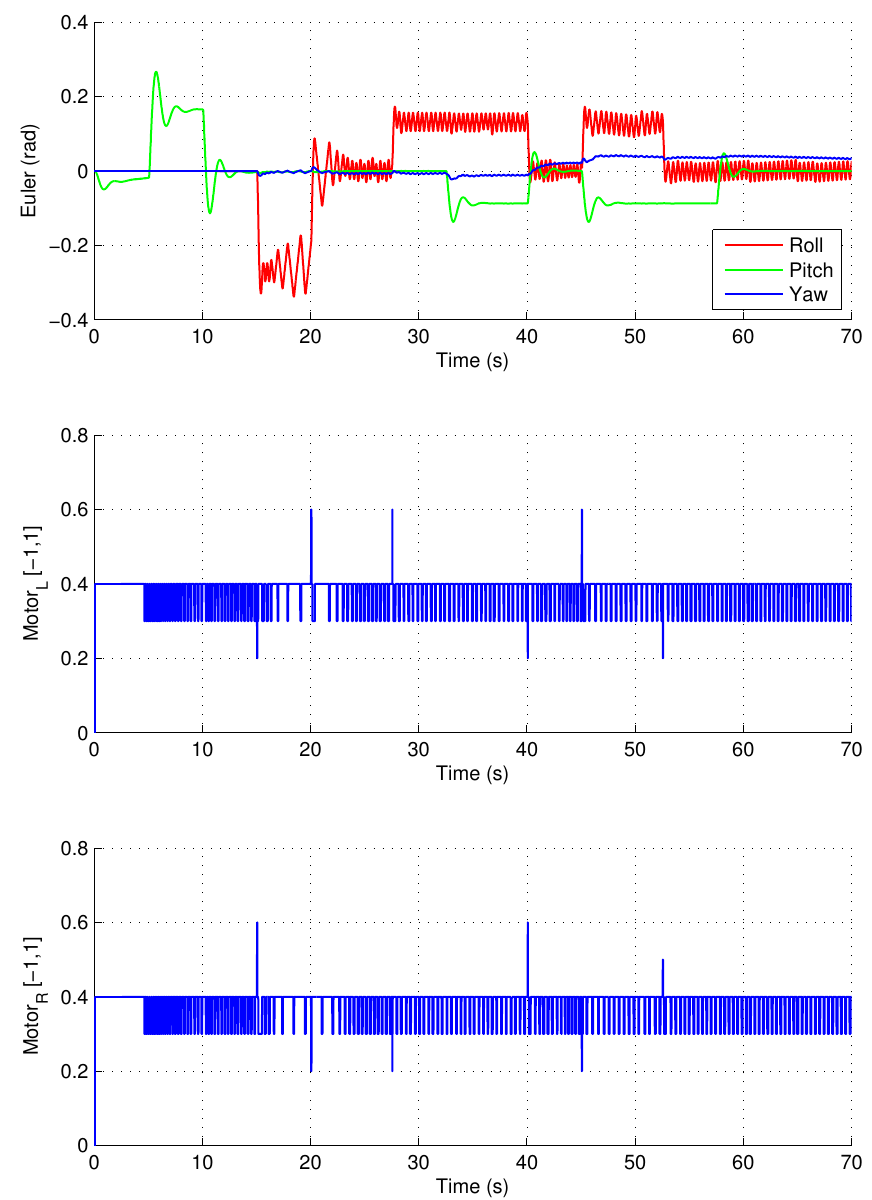
Figure 12. Thrust signal against modifications in φ and θ